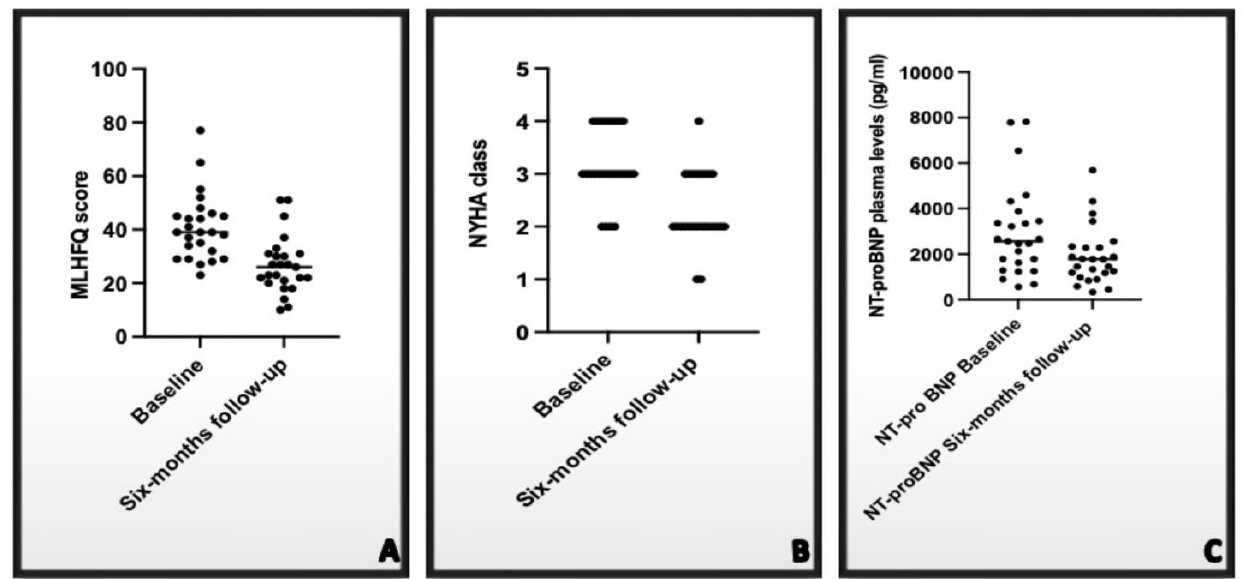
Figure 2. Effects of CCM therapy on NT-proBNP plasma levels (panel ( A )), NYHA class (panel ( B )), and MLHFQ score (panel ( C )). NT-proBNP: N terminal-pro brain natriuretic peptide; NYHA: New York Heart Association; MLHFQ: Minnesota Living with Heart Failure Questionnaire.